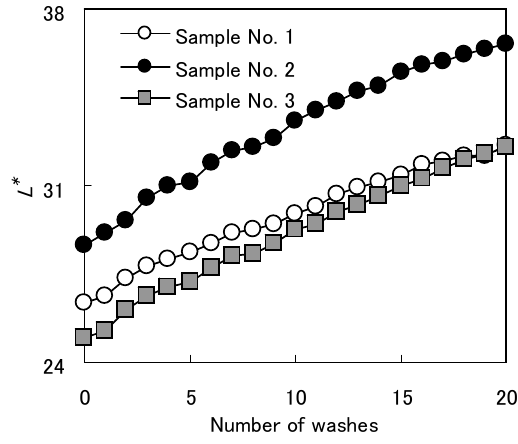
Figure 6. Number of washes and L* value of samples [12].